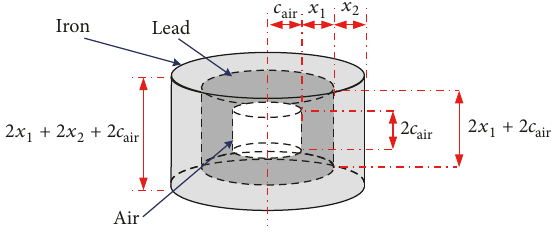
Figure 3: 3 D configuration of